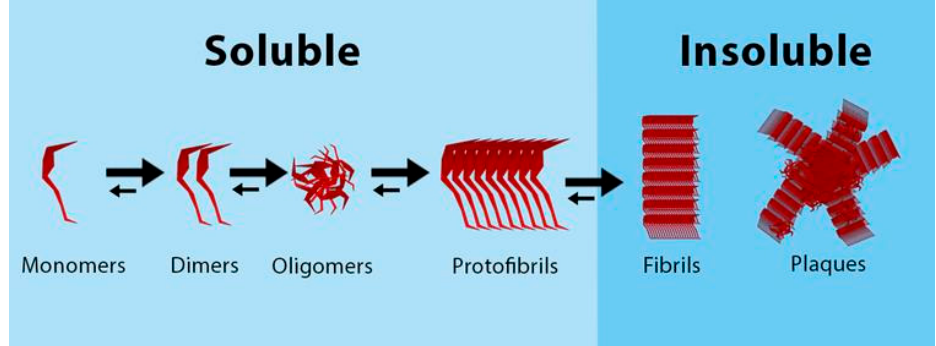
Figure 2. Aggregation of proteins from monomers to plaques. Soluble monomers aggregate together to form dimers and oligomers, that can form soluble protofibrils. These protofibrils aggregate to form insoluble fibrils, that can form plaques. The process is dynamic and bidirectional, therefore complex aggregates can disaggregate into less complex aggregates. Modified from Kok et al., 2022